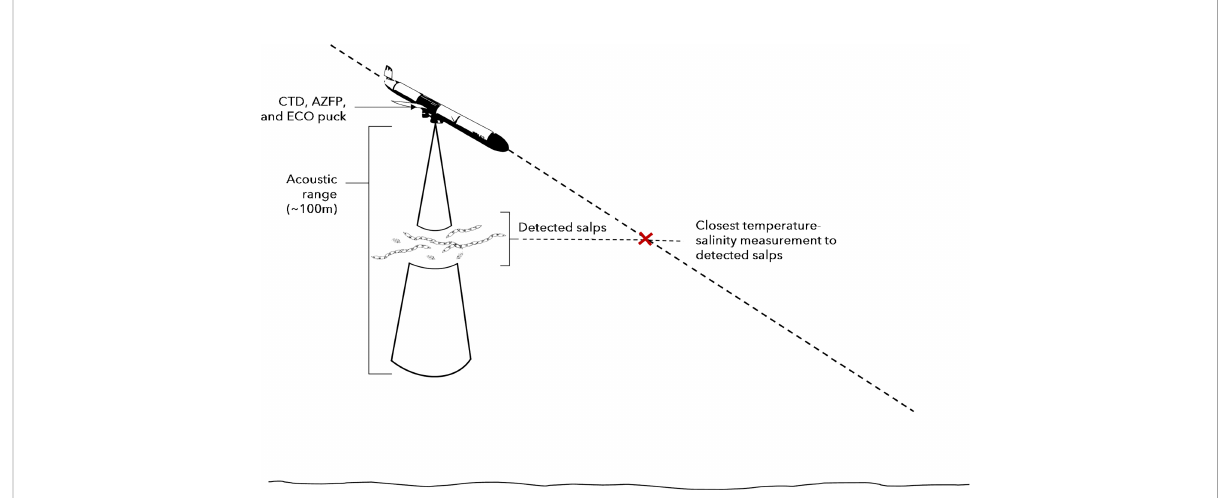
FIGURE 2 Illustration of method used to associate acoustically detected groups of salps with closest temperature and salinity measurements from glider- borne